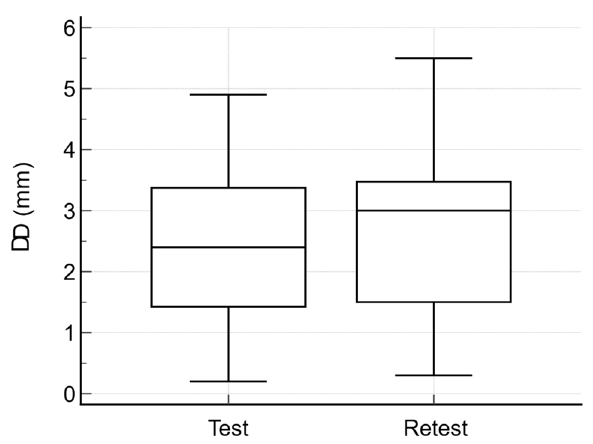
Figure 3. Side-to-side differences in tibial translation ( Δ D).